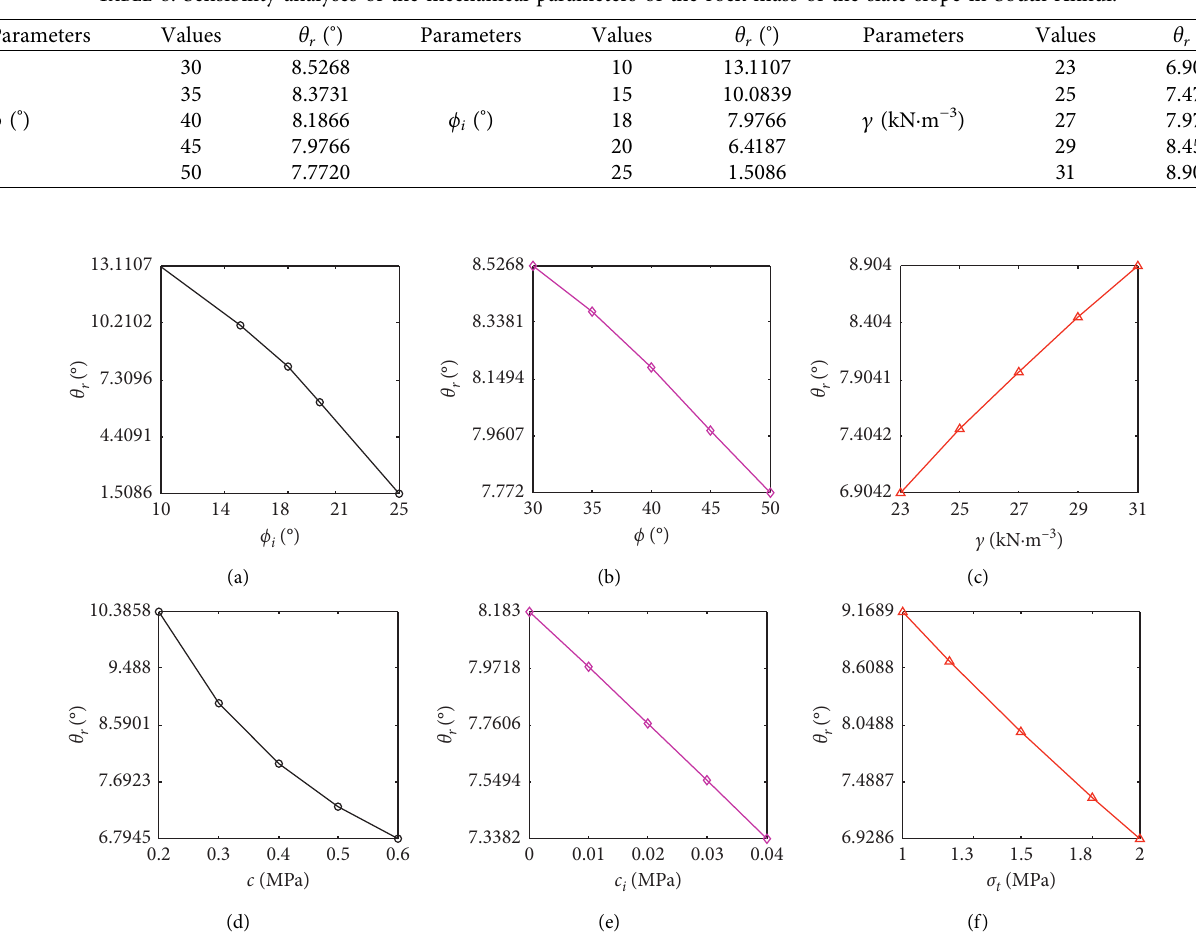
Figure 11: Sensitivity analyses of the mechanical parameters of the rock mass of the slate slope in South